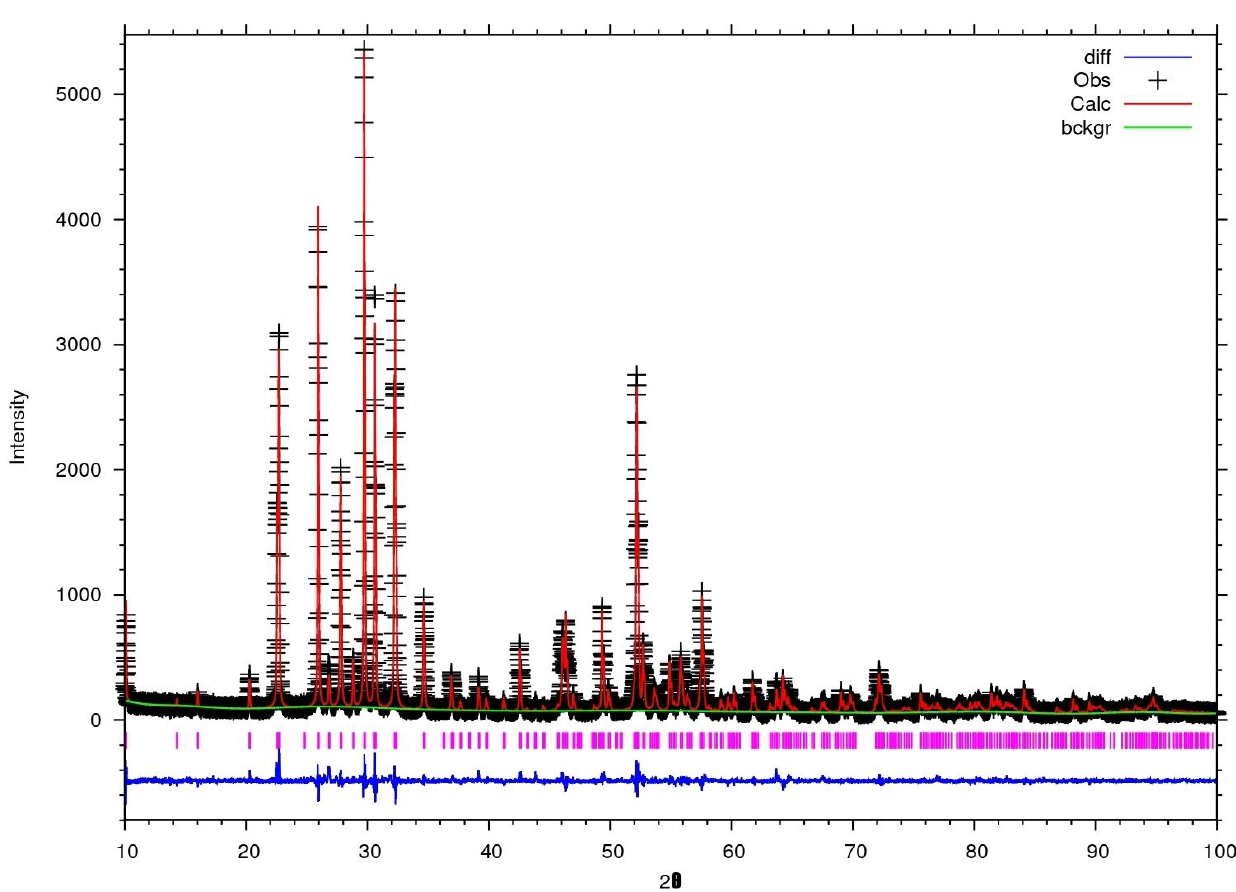
Figure 1. X-ray Rietveld refinement of crystalline phase Ba 0.54 Na 0.46 Nb 1.29 W 0.37 O 5. Table 1. Rietveld refinement data of the crystalline phase Ba 0.54 Na 0.46 Nb 1.29 W 0.37 O 5.